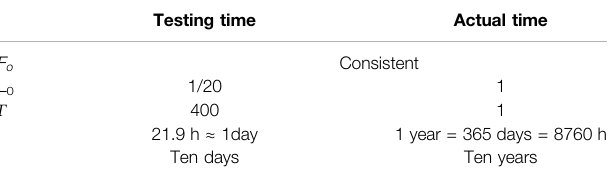
TABLE 1 | Actual/testing time